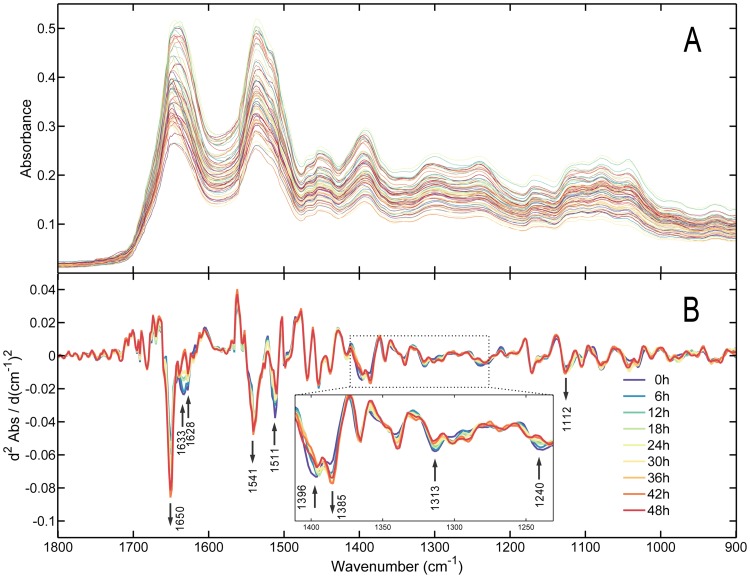
The raw ATR–FTIR spectra and average second-derivative spectra.(A) Raw ATR–FTIR spectra obtained from postmortem plasma. (B) Average SNV-corrected, second-derivative ATR–FTIR spectra of the calibration set plasma obtained from different PMIs. Arrows indicate the major change trends in the intensity of the marked bands with PMI. Inset: local magnification image corresponding to the frame area marked in.